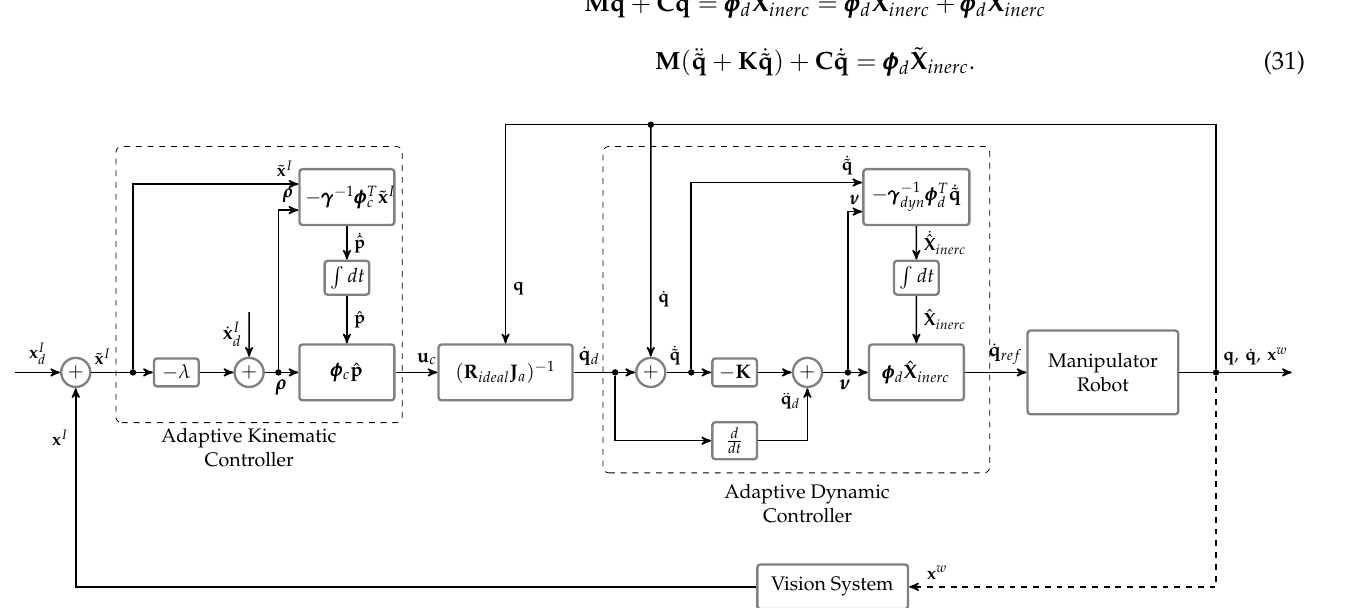
Figure 2. Adaptive visual servoing control system with dynamic